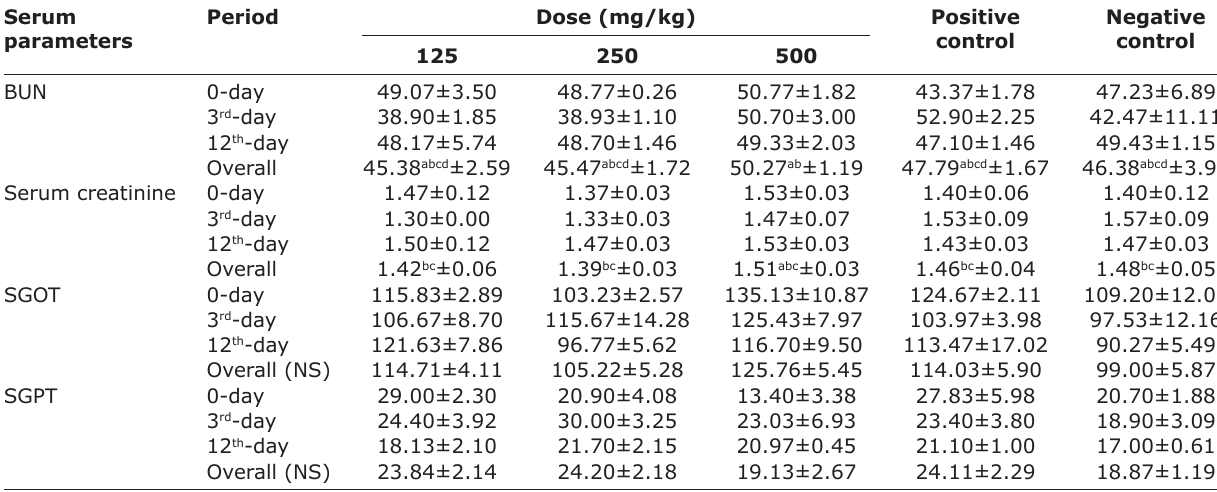
Table-4: Effect of I. tinctoira ethanolic extract on serum parameters (mean±SE) in sheep naturally infected with GI nematodes. Serum